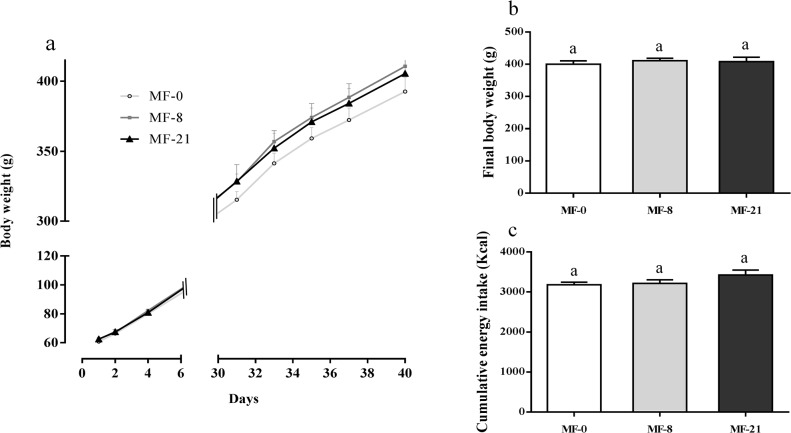
Effect of tricaprylin on body weight gain and food intake in the MF groups.(a) Body weight gain in gram. Two-way repeated measurement ANOVA: effect of the diet, P = 0.5275. (b) Final body weight in gram; Kruskal-Wallis (K-W) test: P = 0.9098. (c) Cumulative energy intakes in kcal. K-W test: P = 0.3393. Results are expressed as mean ± SEM.